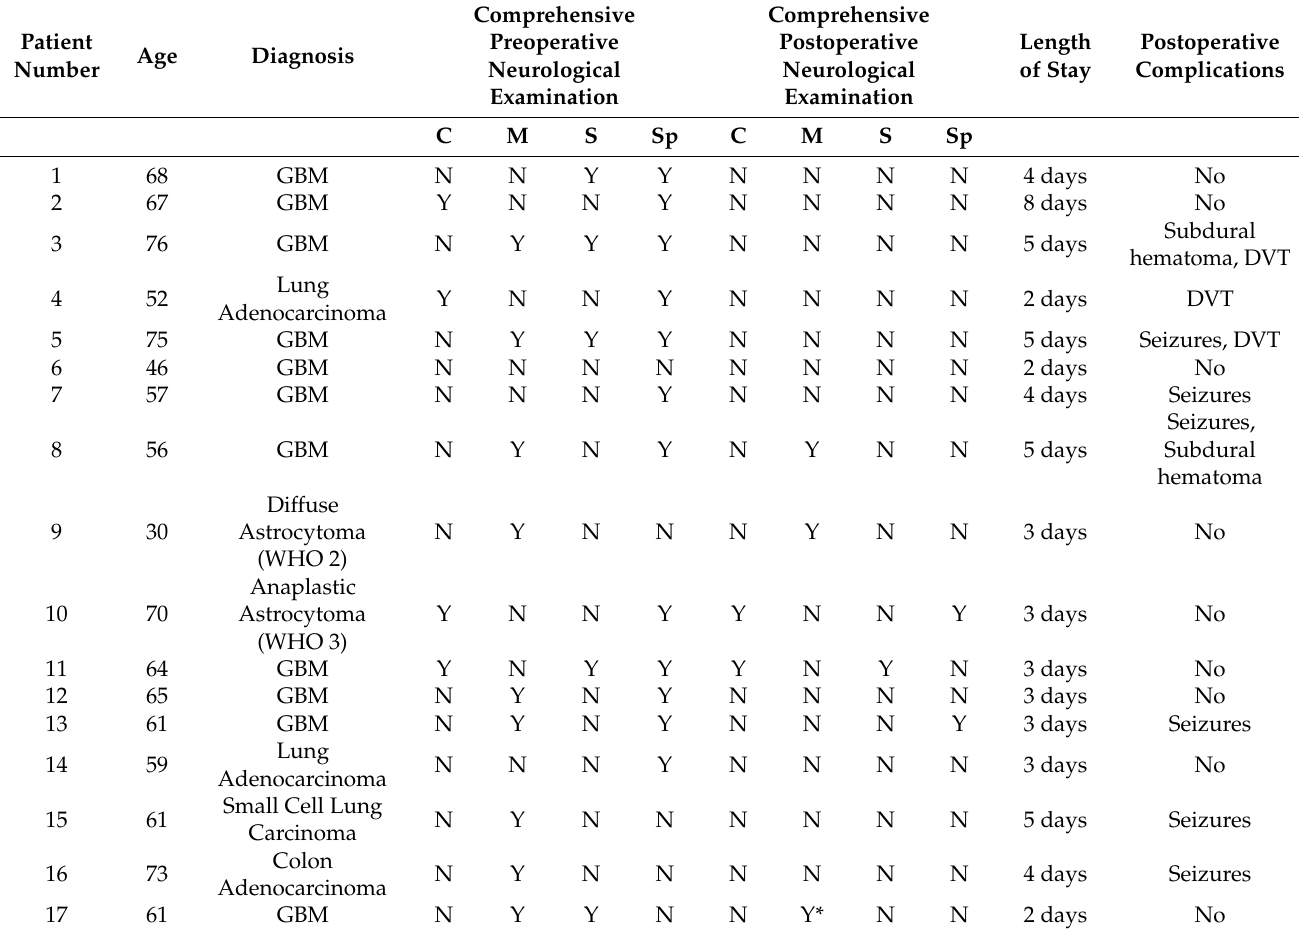
Table 1. Patients with Diagnoses and Outcomes.